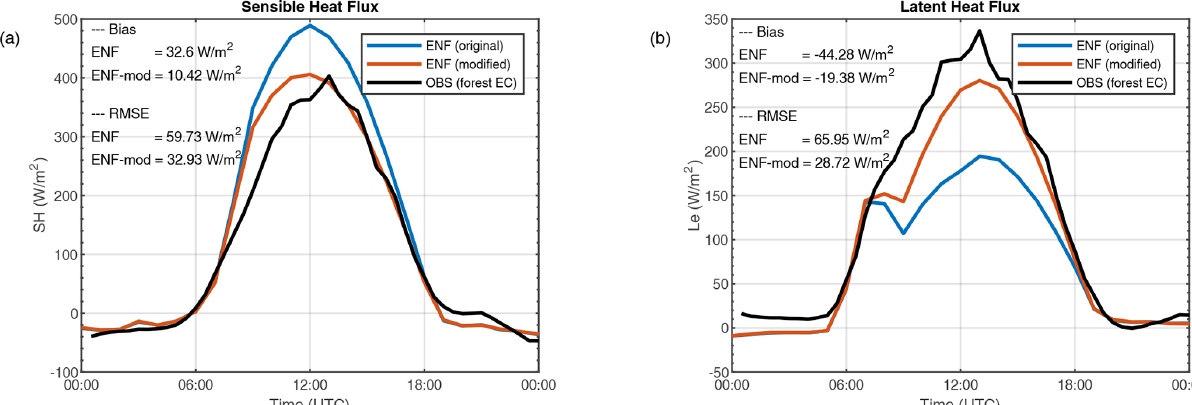
Figure 10. (a) Sensible heat flux (SH) from two simulations with the evaluated pixel completely covered by the original ENF (conifer, blue) and ENF-mod (conifer with parameters modified, red). The observations made over the forest site are indicated with a black line. (b) Same for the latent heat flux (Le). The model results were obtained using the Noah-MP land surface model for 19 June 2011. The biases and root mean square error (RMSE) are included.